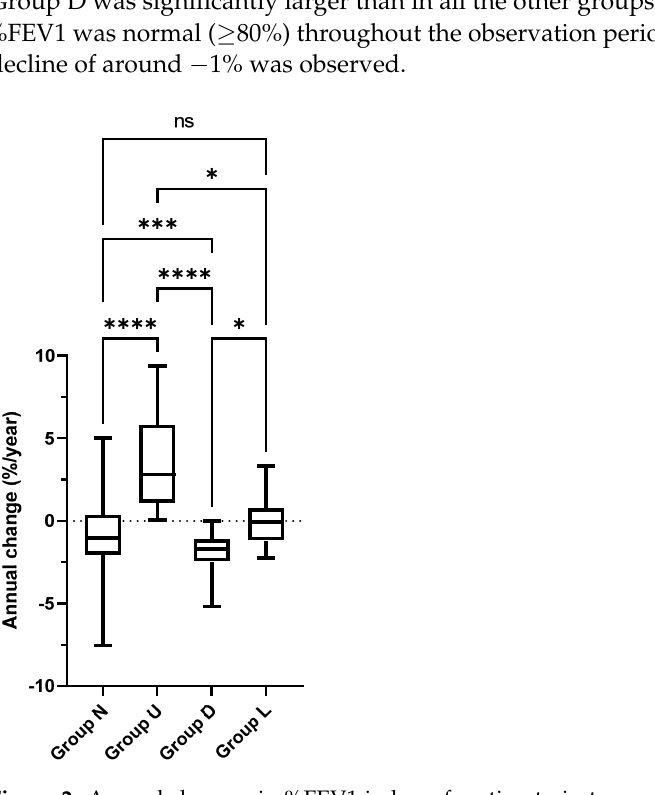
Figure 2. Annual changes in %FEV1 in lung function trajectory groups. p < 0.0001 with Kruskal– Wallis test. **** p < 0.0001, *** p < 0.001, and * p < 0.05 with Dunn’s multiple comparison test. n.s.: not significant.